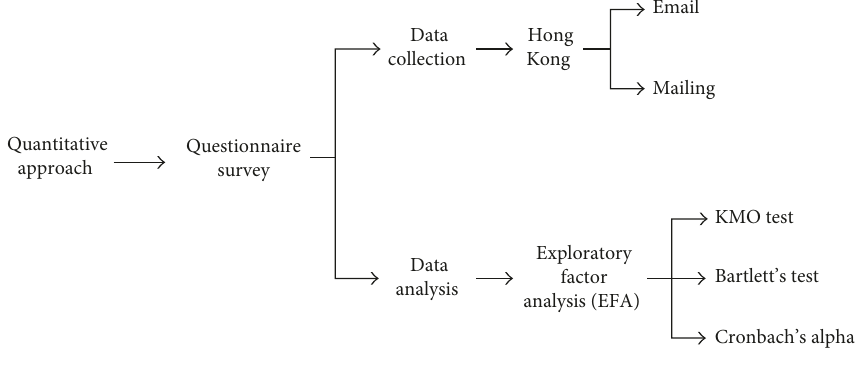
Figure 2: Research